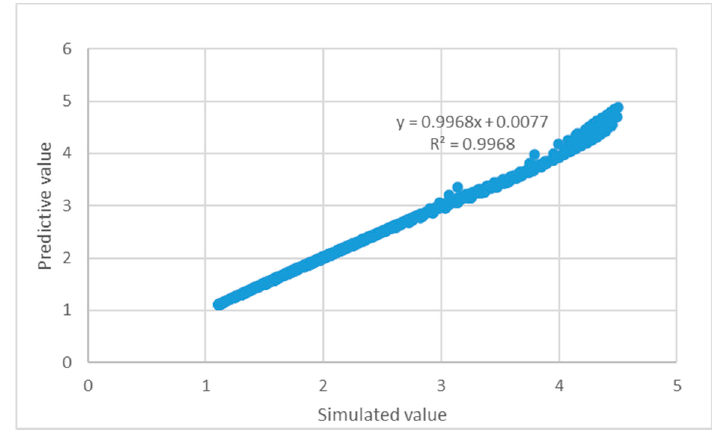
Figure 3. Comparison between simulated and predicted values.